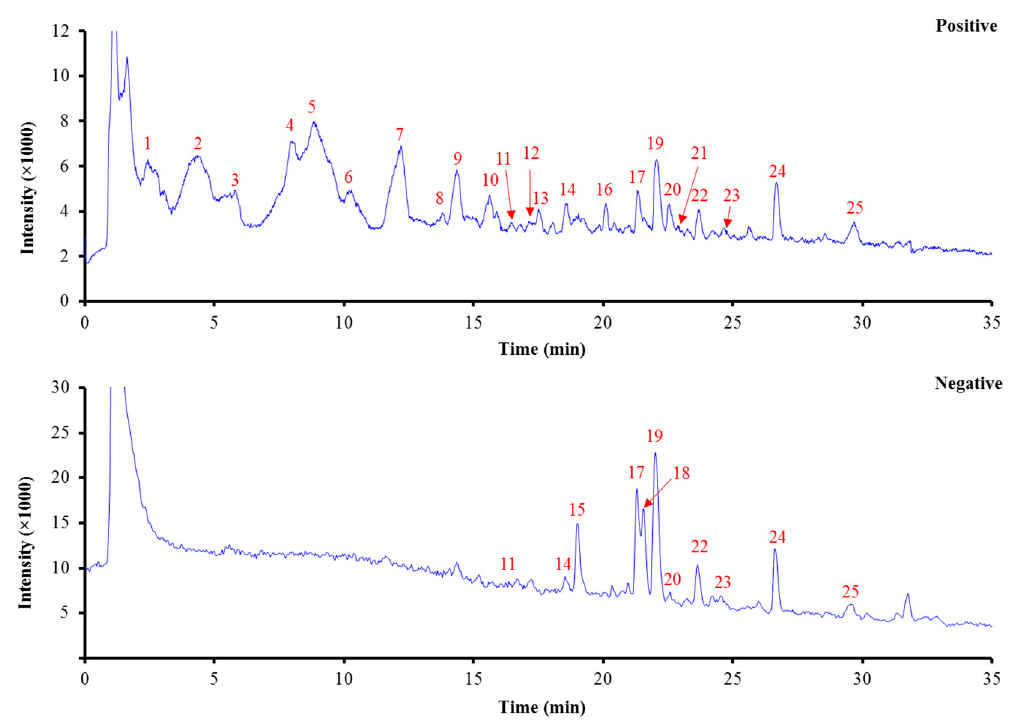
Figure 3. Total ion current (TIC) chromatograms of L. chinensis in both positive and negative ionization modes.